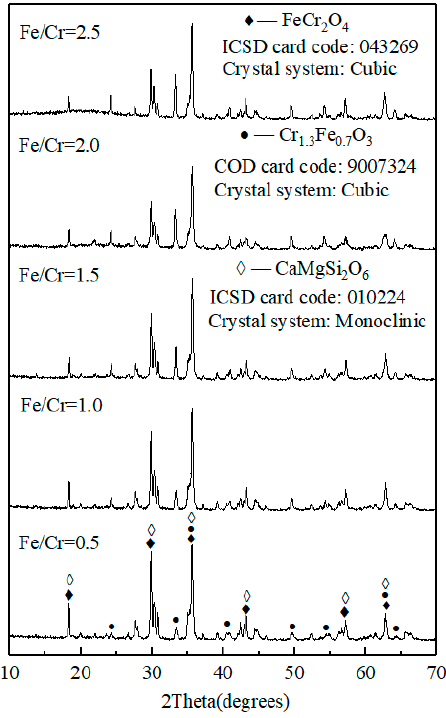
Figure 4. XRD patterns of ceramic tiles with di ff erent Fe / Cr molar ratio sintered at 1150 ◦ C for 30 min.